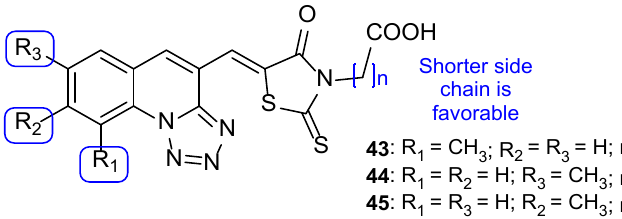
Figure 24. Chemical structures of 43 – 45 and SAR [104]. Regarding the previous compounds, new hybrids were synthesized by Kategaonkar et al. by replacing the rhodanine fragment with an ethoxy phosphonyl group [105]. These compounds were tested against C. albicans and A. niger and demonstrated moderate antifungal activity. Compound 46 (Figure 25) showed comparable activity to that of griseofulvin, the standard drug (MIC value of 22 µM vs. 28 µM for griseofulvin) against C. albicans . Compounds 47 , 48 , and 49 (Figure 25) also presented similar antifungal activity as griseofulvin, with MIC value of 22, 22, and 21 µM, respectively (griseofulvin value of MIC was 28 µM) against A. niger . These results suggest that the presence of a methyl group at C-7 in 46 results in increased antifungal activity against C. albicans and the presence of methyl, methoxyl, and ethoxyl groups at C-8 ( 47 , 48 , and 49 , respectively) enhanced antifungal potency against A. niger [105].